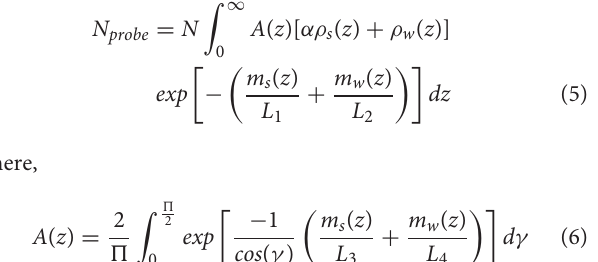
spatial distribution of REFKDT where smaller values of